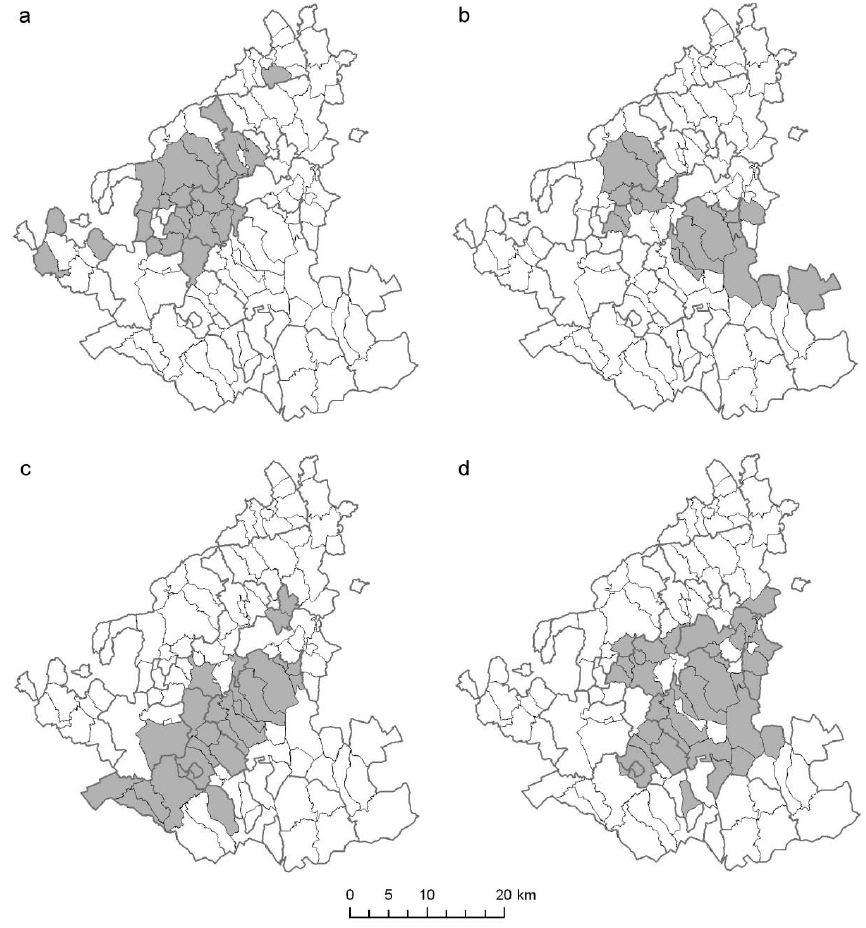
Fig. 5. Spatial extent of reported damage during four outstanding extreme events, expressed for the land registers of individual settlements (in grey): (a) 25 June 1825, (b) 20 May 1847, (c) mid-June 1847, (d) 29 June